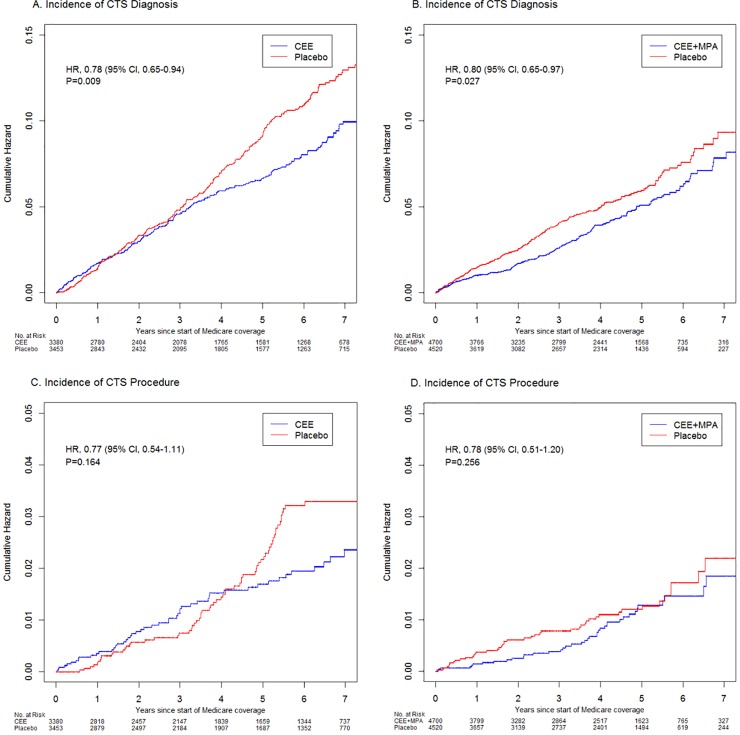
Cumulative hazard curves for carpal tunnel syndrome outcomes in the women’s health initiative (whi) estrogen alone and the estrogen and progestin trials during the intervention periods1.Cumulative hazard curves for CTS diagnosis in the Women’s Health Initiative CEE (panel A) and the CEE+MPA (panel B) trials during the intervention periods. Comparable plots are shown for CTS procedure in the CEE (panel C) and the CEE+MPA (panel D). The intervention reduces the cumulative hazard of CTS cases by 22% in the CEE trial and by 20% in the CEE+MPA trial. A similar trend is seen for CTS procedures but it was not statistically significant. Cox proportional hazard models were used where time zero started when each participant’s Medicare coverage started. CEE, conjugated equine estrogens; MPA, medroxyprogesterone acetate; CI, confidence interval; HR, hazard ratio. 1Hazard ratios (HR) and 95% confidence intervals (CI) estimated from Cox proportional hazards models; p-values based on Wald Chi-square statistics.